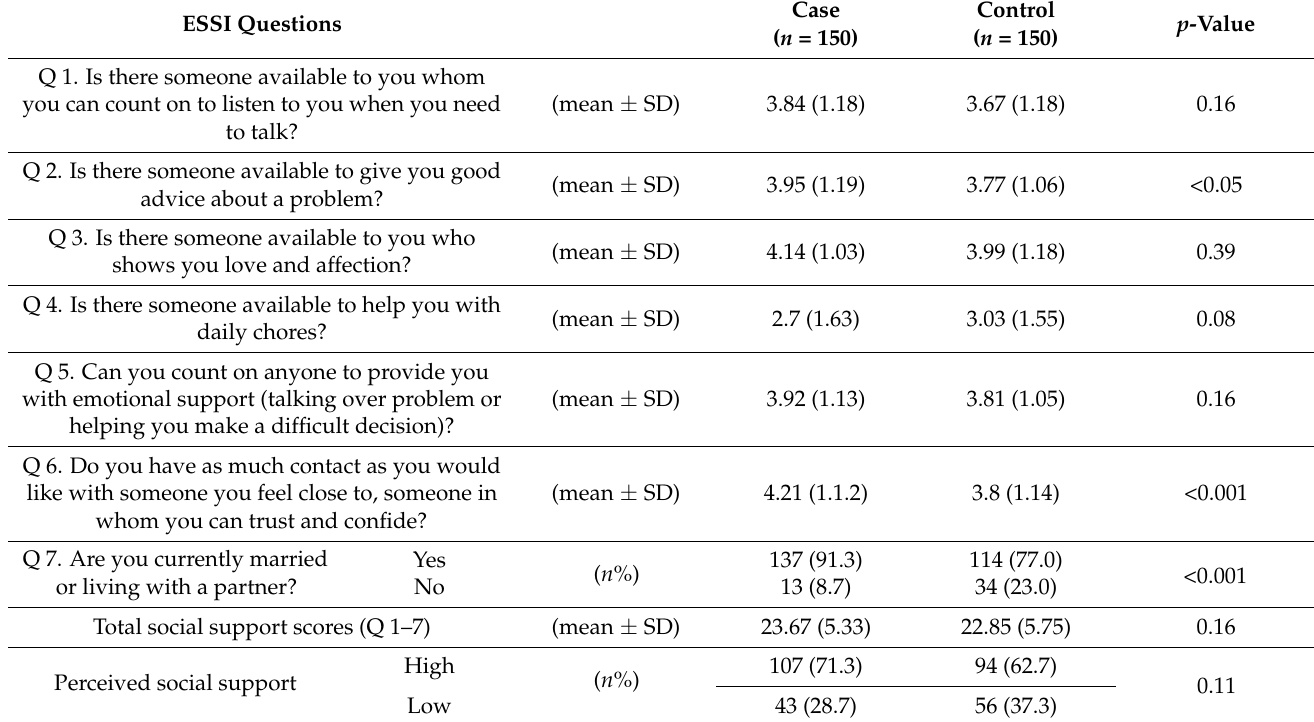
Table 3. Social support between case and control.